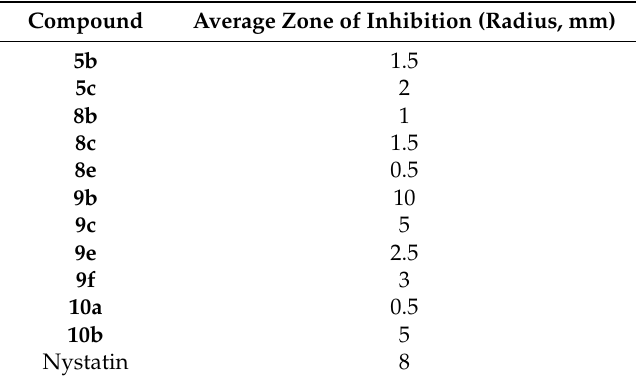
Table 1. Selected bioassay results against Schizosaccharomyces pombe